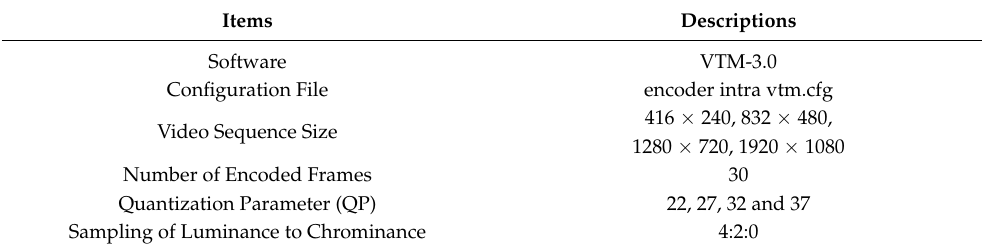
Table 4. The environments and conditions of simulation.